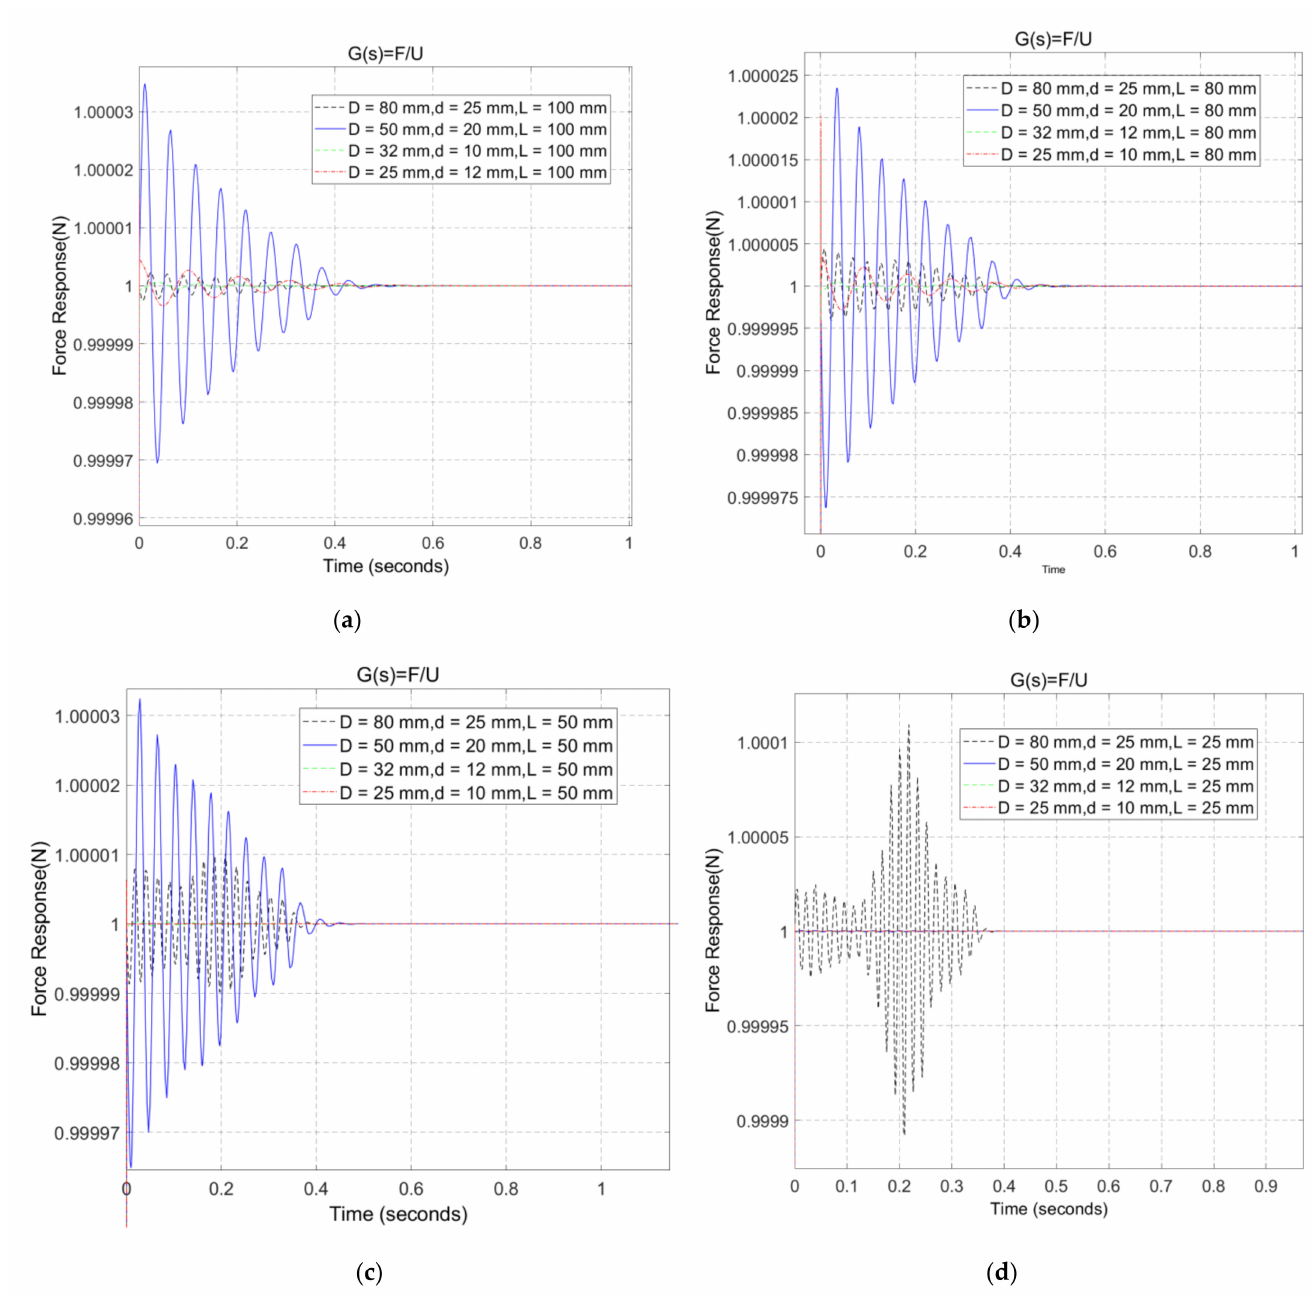
Figure 10. Output force response curves of different cylinder diameters. ( a ) L = 100 mm; ( b ) L = 80 mm; ( c ) L = 50 mm; ( d ) L = 25